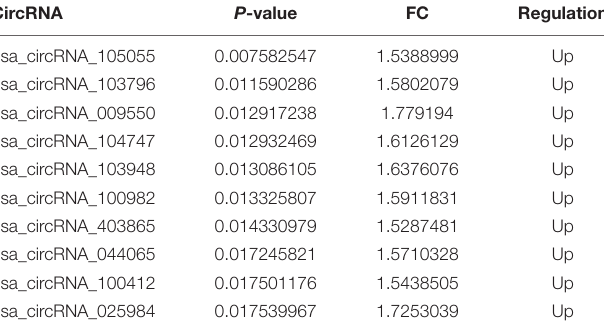
TABLE 2 | Top 10 upregulated circRNAs.